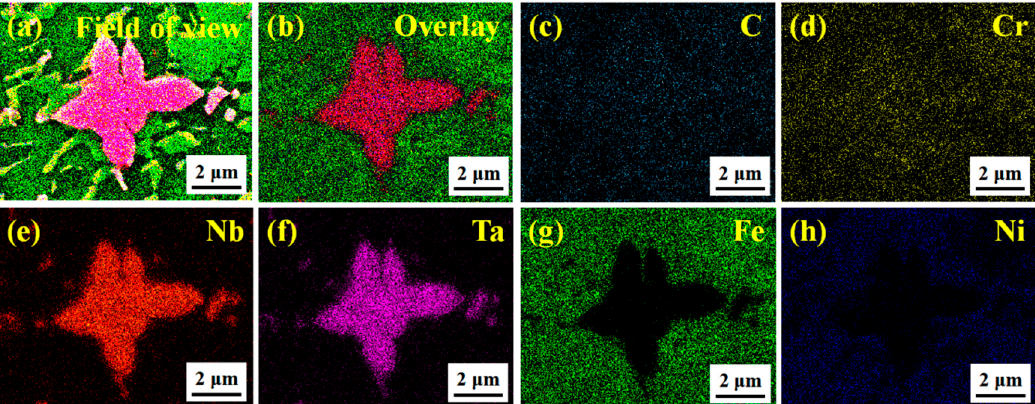
Figure 7. Typical area mapping of S6 in Figure 4. ( a ) Field of view; ( b ) overlay; ( c ) C; ( d ) Cr; ( e ) Nb; ( f ) Ta; ( g ) Fe; ( h ) Ni. Figure 8 is schematic diagrams of the cross-sectional structure change and heat dissipation. Viewed from the top of the matrix, the circular laser spot is continuously output to form a multi-melt lap, corresponding to the cross-sectional structure change and the heat dissipation. With the increase of the ceramic micro-particle content, the thickness of the composite coating increases and heat dissipation capacity weakens, causing a gradually increasing curvature of the bonding interface. Additionally, the changes of (M:Nb,Ta)C morphology (irregular granular, spherical, polyhedral and petal shape), size (sub-micron and micron) and number (increased) continuously inhibits the growth of crystal grains. S1 means that it does not contain any composite carbides and the (M:Nb,Ta)C form is a small amount of irregular granular in S2. S4 indicates that the white phase grows into a spherical shape and even a polyhedron in S5. However, some of the white phases appear to be clustered into micron-sized petal shapes in S6.